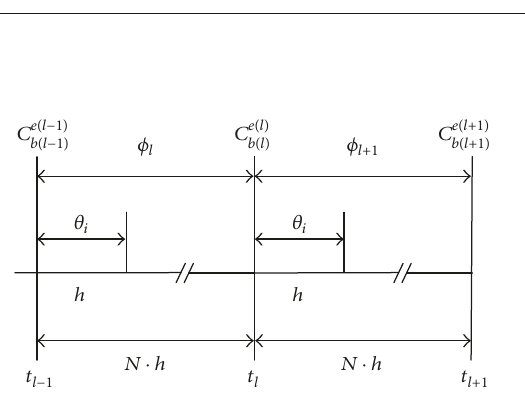
Figure 2: Conventional updating